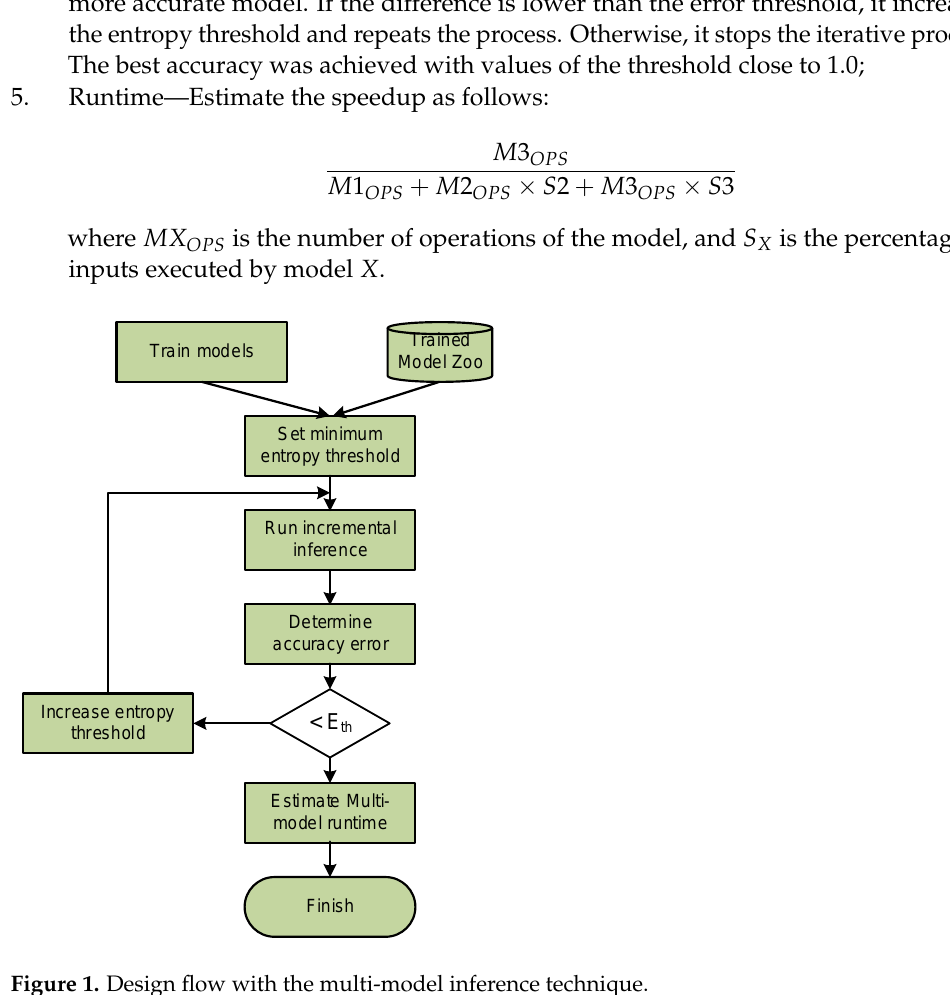
Figure 1. Design flow with the multi-model inference